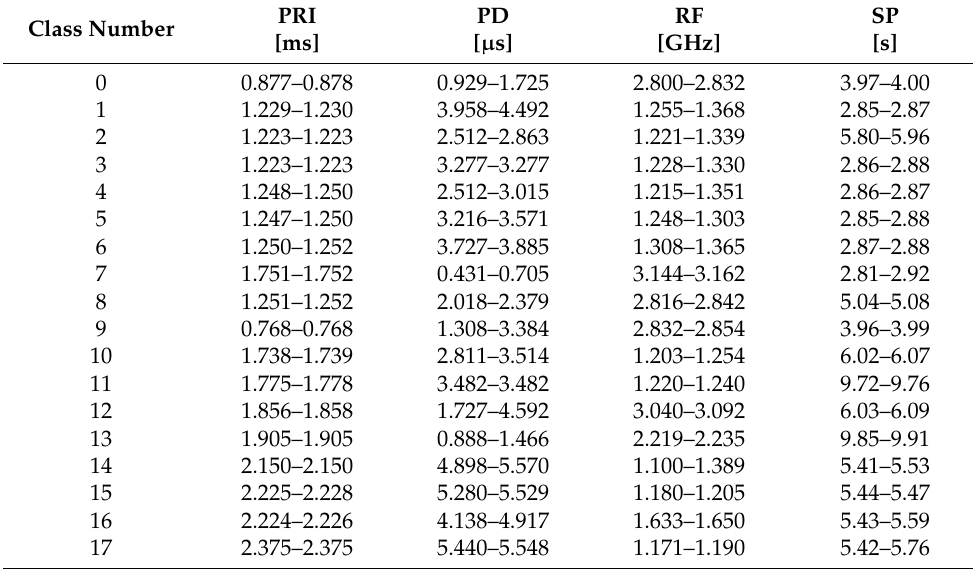
Table 1. The confidence intervals of radar signal parameters for 18 classes examined.